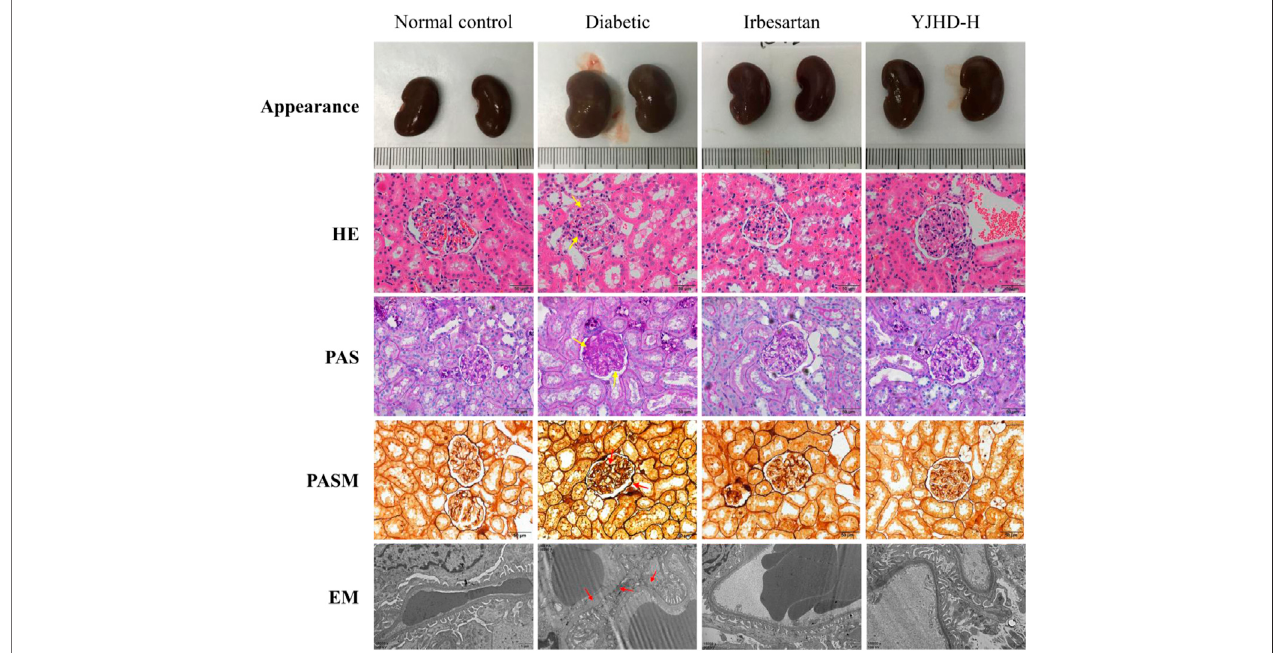
FIGURE 3 | Yiqi Jiedu Huayu decoction (YJHD) attenuated renal histological damage. Renal pathological changes were analyzed by renal appearance; hematoxylin-eosin,periodic-acidSchiff,andperiodic-acidSchiffmethenaminestaining;andtransmissionelectronmicroscopy.Inthediabeticgroup,thepositivepartsof the lesions are marked with